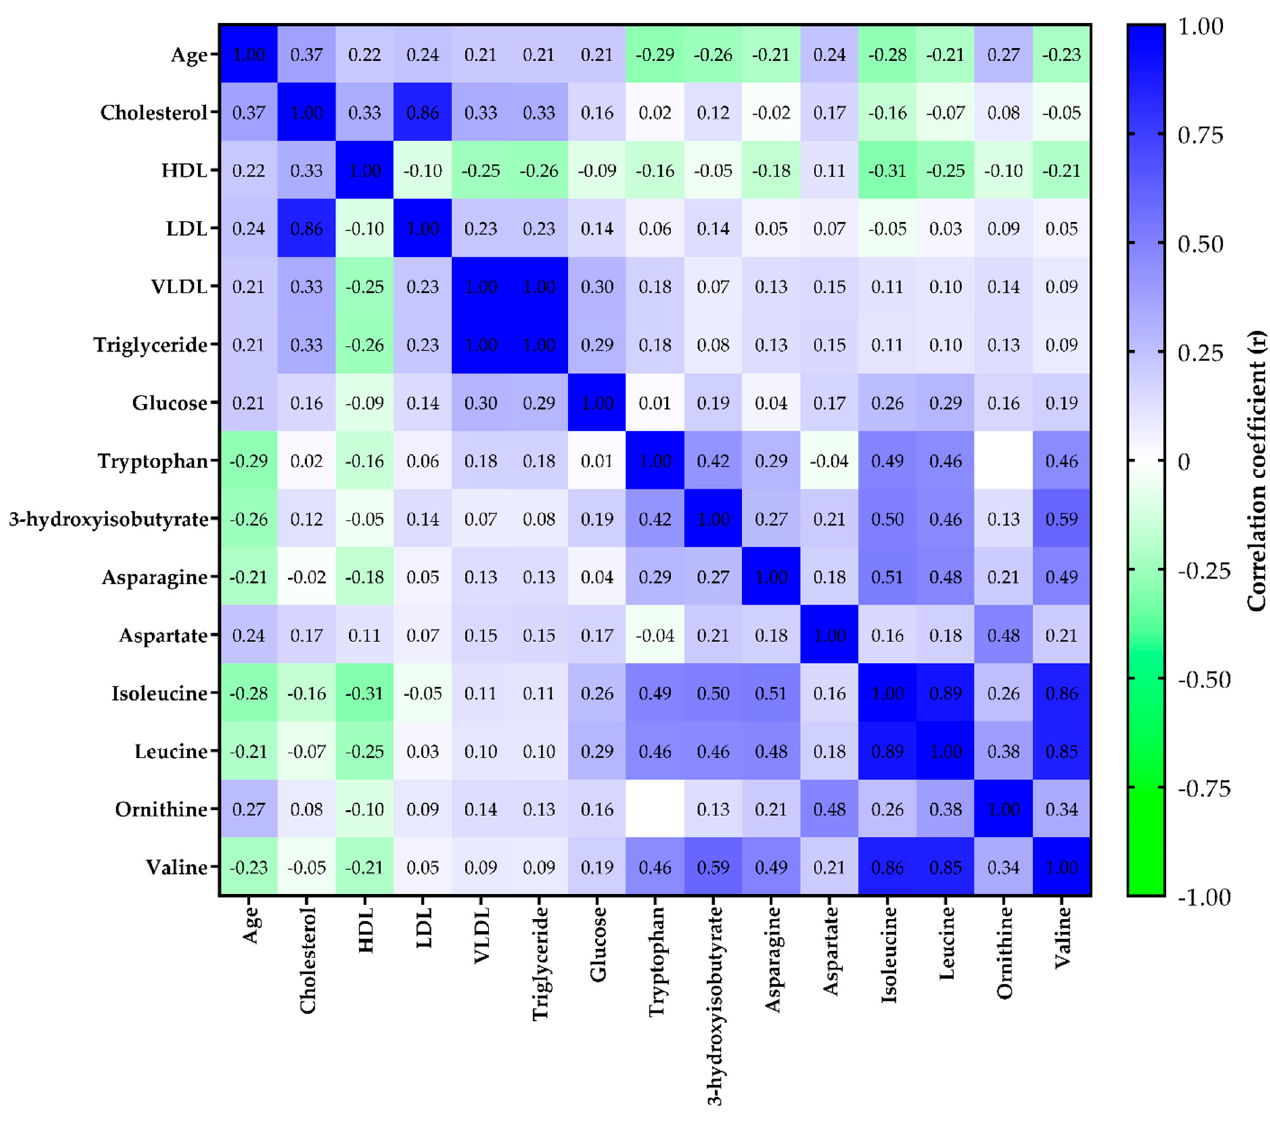
Figure 1. Overall correlation heatmap between age, clinical markers, and metabolite levels. Blue and green colors represent positive and negative correlations (r), respectively. High-density lipoprotein (HDL); Low-density lipoprotein (LDL); Very low-density lipoprotein (VLDL).